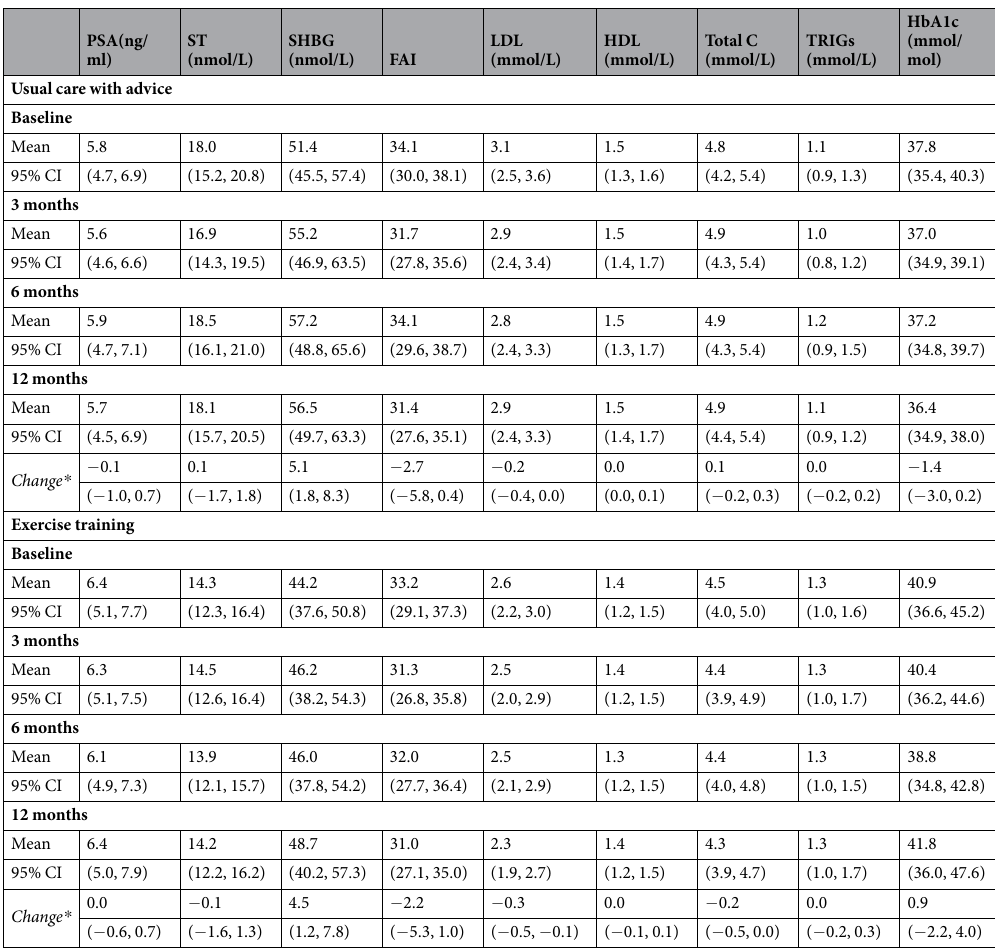
Table 3. Safety and other biomarkers from baseline to 12 months of follow-up. PSA = prostate specific